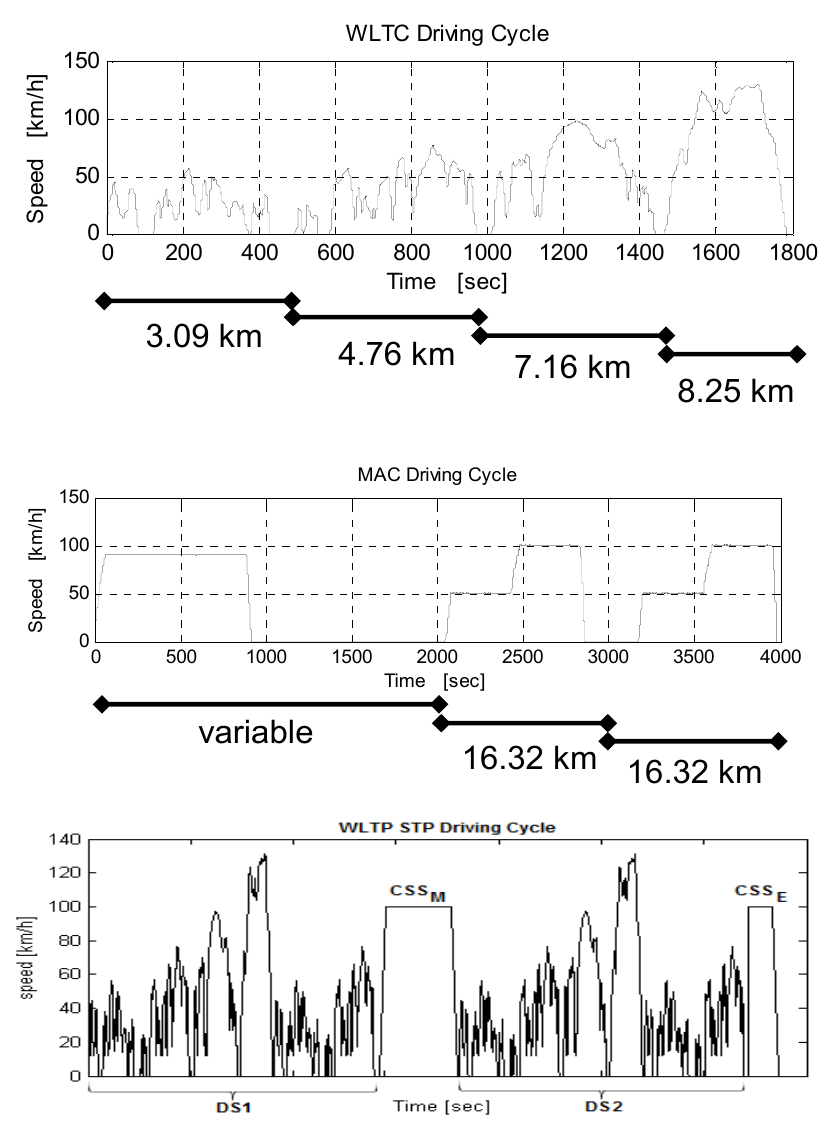
Figure 7. Driving cycles adopted: WLTC, MAC, and WLTP STP [42–44]. Table 3. Laboratory and on ‐ road driving tests.